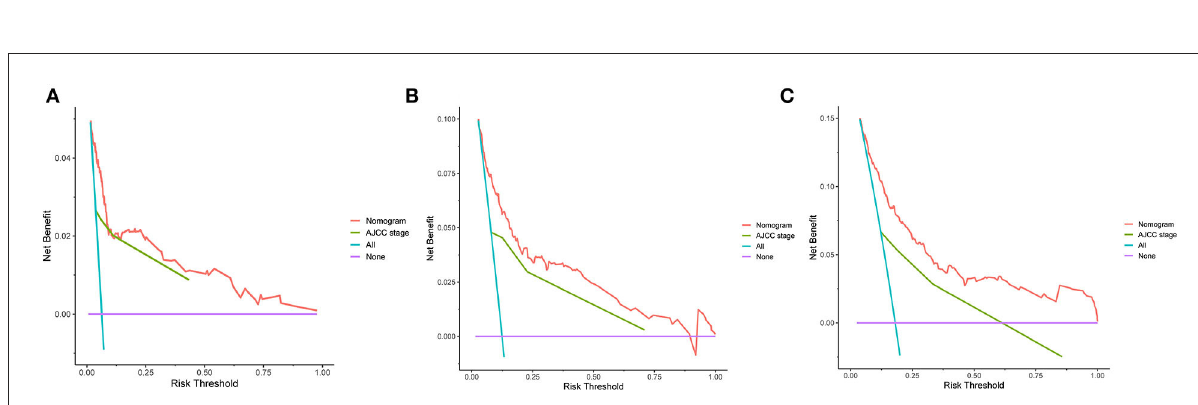
FIGURE5 DCA curves. (A–C) DCA curves of the nomogram and the traditional AJCC staging for 1-, 3-, and 5-year overall